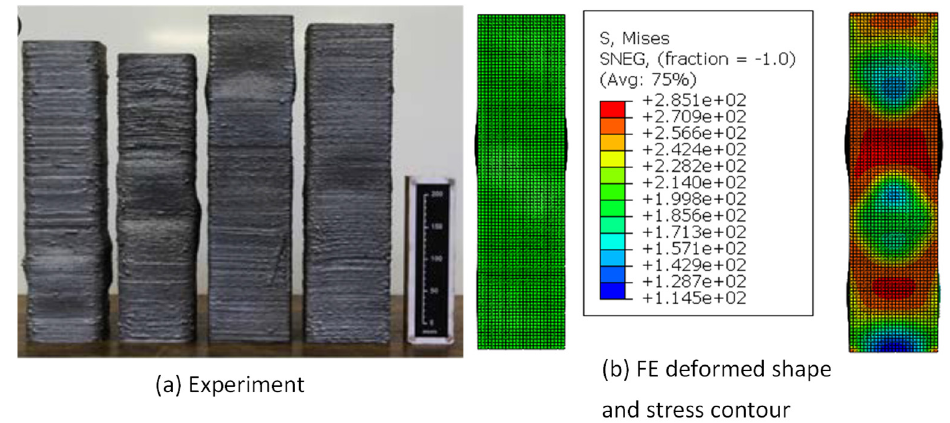
Figure 6. Experimental [17] and FE failure modes.